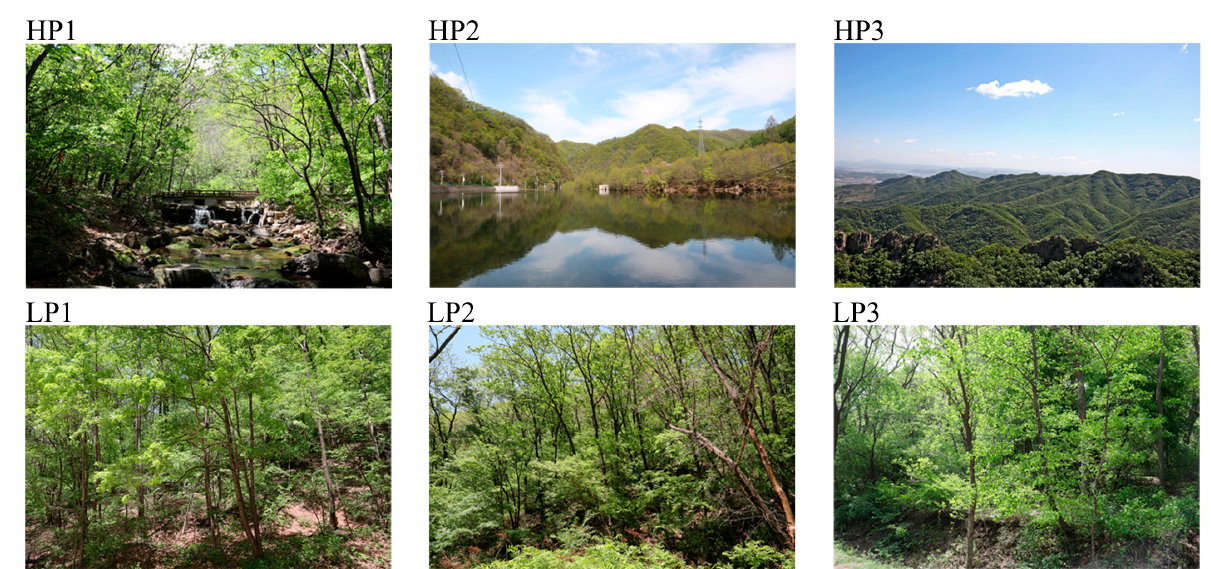
Figure 3. Experimental stimuli. Three high-preference landscapes, namely, dynamic waterscape HP1 (from Phoenix Mountain National Scenic Area), static waterscape HP2 (from Green Stone Valley National Forest Park) and lookout landscape HP3 (from Phoenix Mountain National Scenic Area); three low-preference landscapes, namely, broadleaf forest landscapes LP1 (from Heyi National Forest Park), LP2 (from Heyi National Forest Park) and LP3 (from Shenyang National Forest Park). This figure was created by the author.